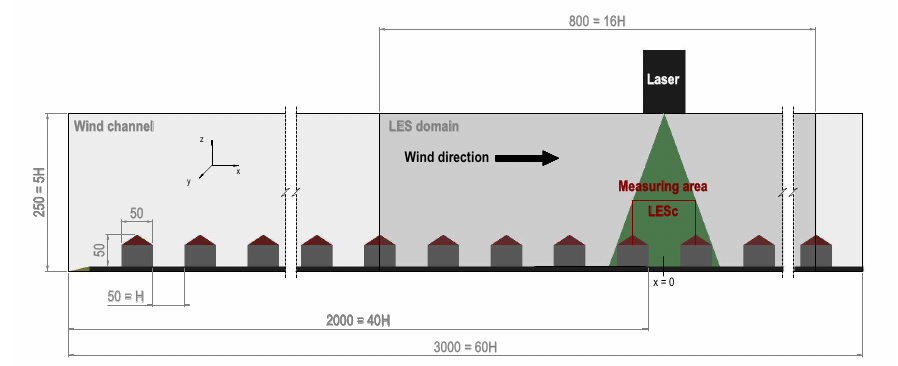
Figure 1. Isometric view of the model positioned in the tunnel test section. The measured area by TR-PIV system is indicated by the red rectangle within the green laser sheet. The dimensions are in